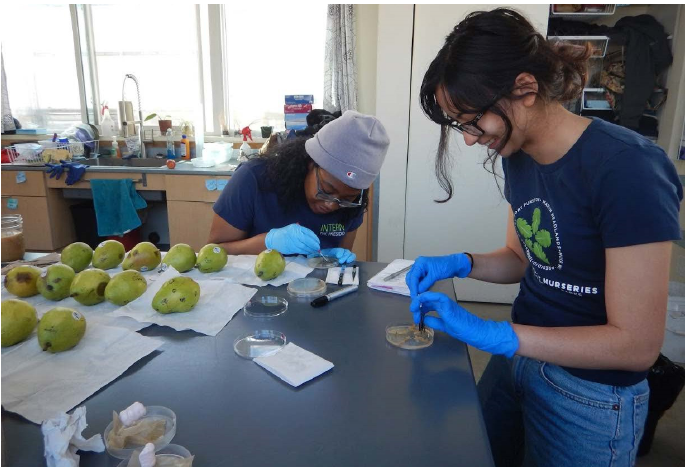
Figure 3. Interns isolating from pear baits to check for Phytophthora at the Presidio Nursery managed by the Golden Gate National Parks Conservancy (GGNPC). Credit: Alisa Shor, GGNPC.